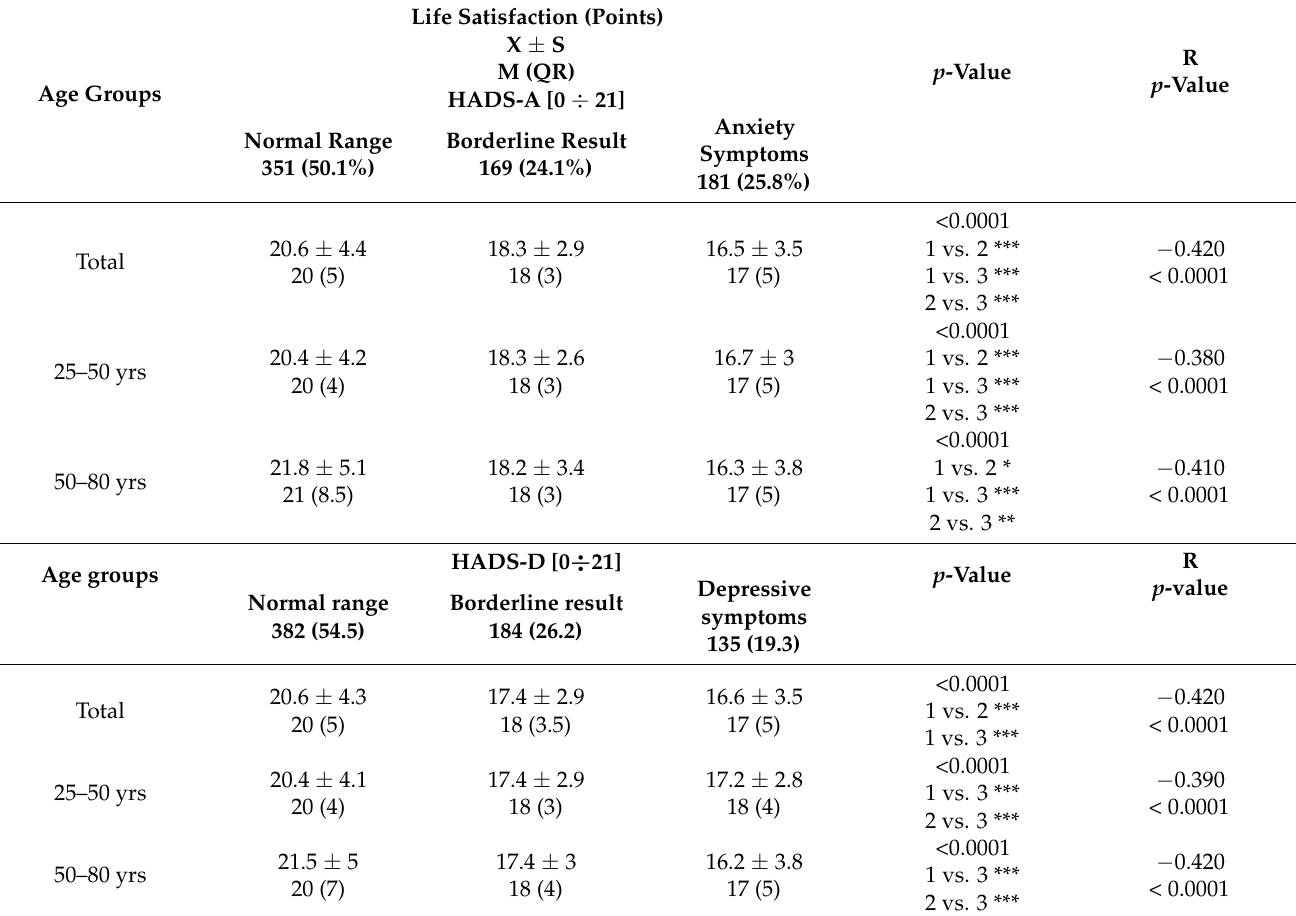
Table 4. Level of satisfaction with life according to the co-occurrence of anxiety and/or depressive symptoms for the total study group (N = 701) and in accordance with the age